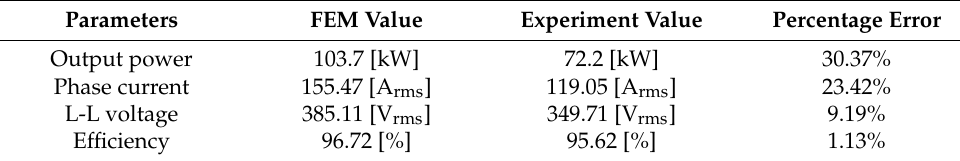
Figure 4. Line to Line voltage and phase current characteristics of STS420-J2 shaft material at load. Table 2. Comparison of STS420-J2 Shaft Material FEM and Experiment Results.